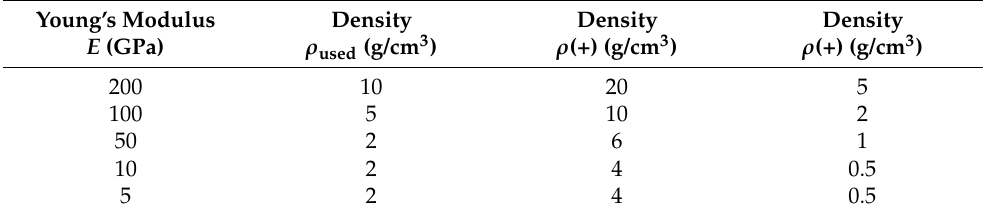
Table 5. Benchmark of densities ( ρ ) as a function of Young’s modulus ( E ).